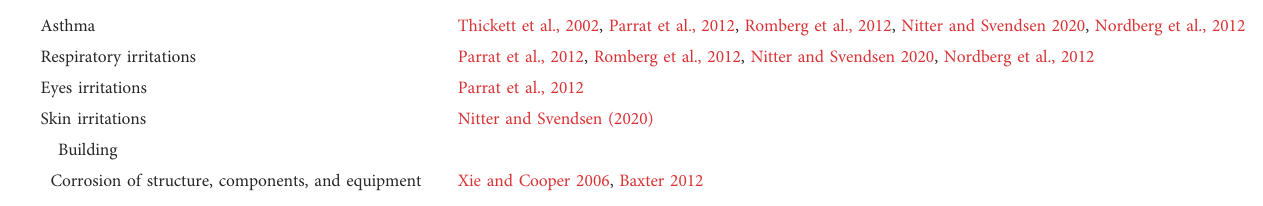
TABLE 1 Effects of NCl 3 on the air of the swimming pool